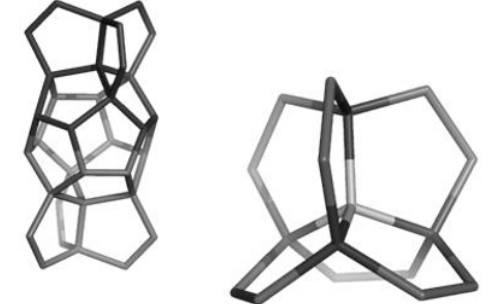
Figure 2. The repeating unit of D